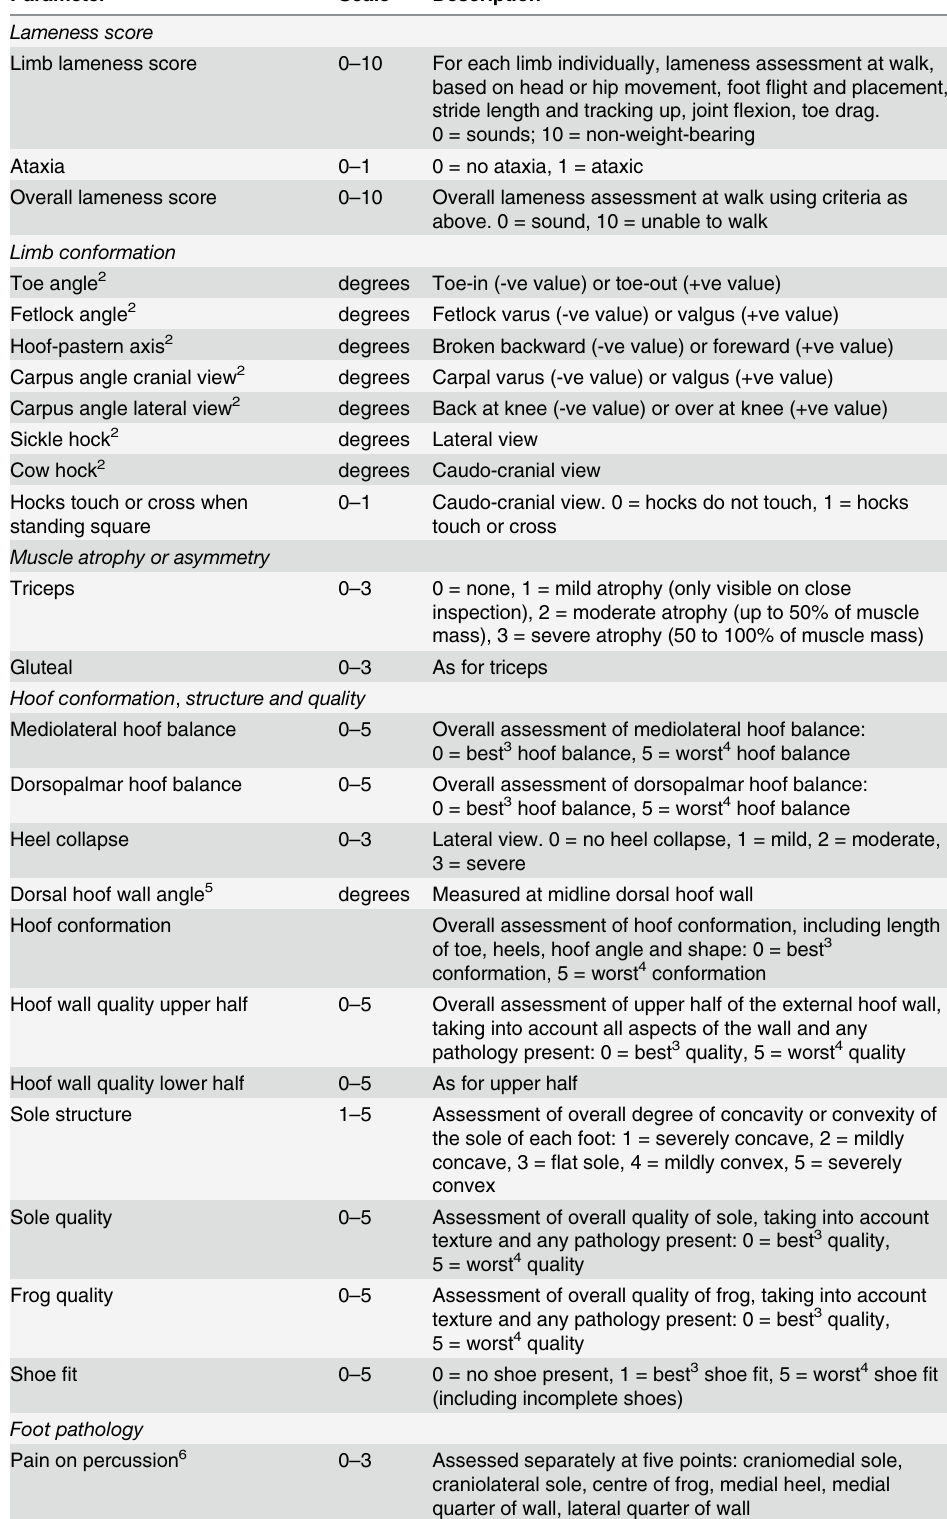
Table 1. Lameness examination protocol used for 862 horses working in Jaipur and its environs, India (adapted from